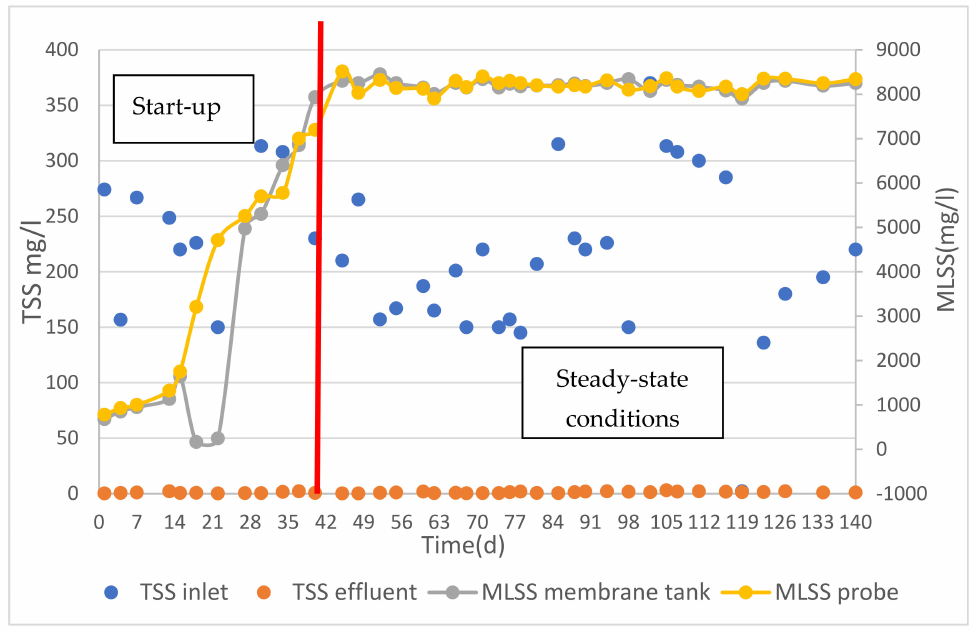
Figure 10. MBR performance in terms of TSS removal.